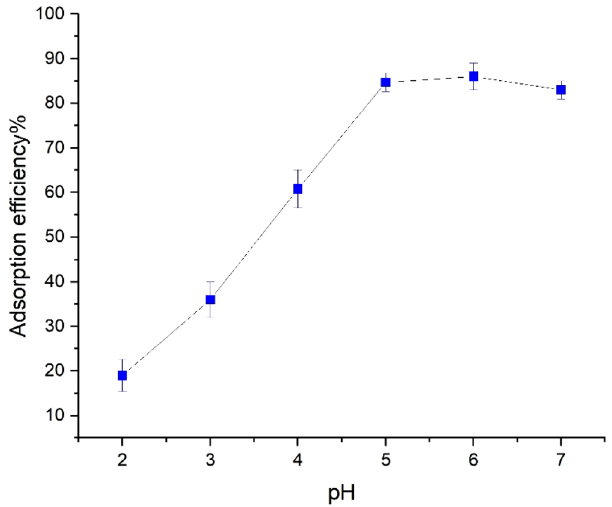
Figure 8. Effect of pH on Pb(II) adsorption (pH range (2–7), Pb(II) concentration (20 ppm), contact time (60 min), volume of the solution (40 ml), adsorbent dosage of 0.04 g, and temperature of 298 K).